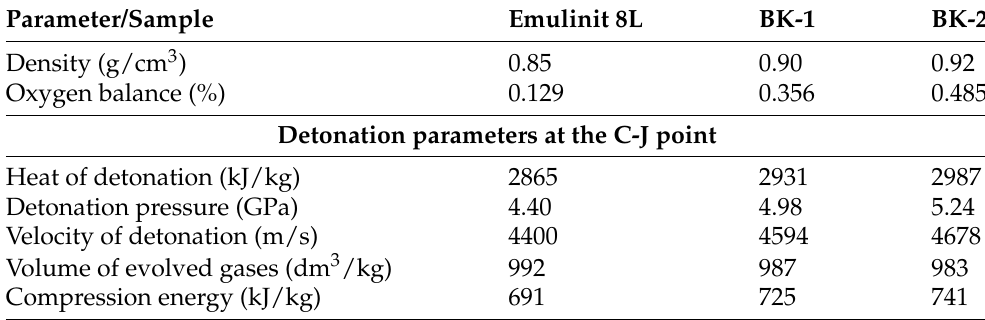
Table 2. Summary of detonation parameters calculated using EXPLO5